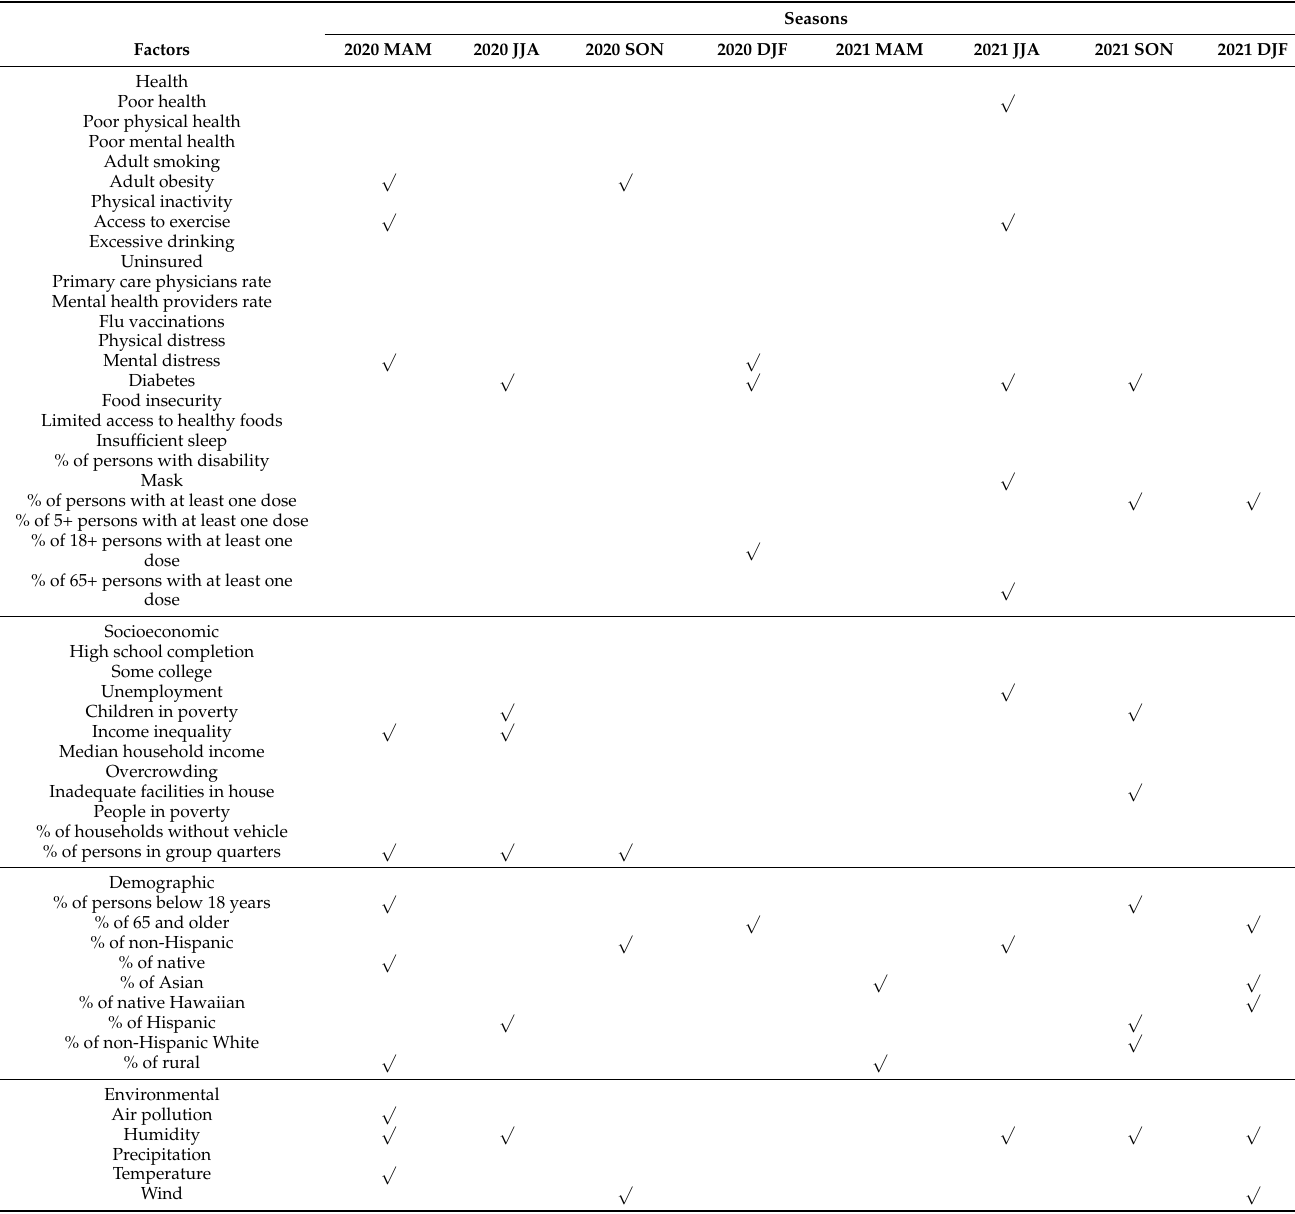
Table A2. Selected variables for each model in each season.